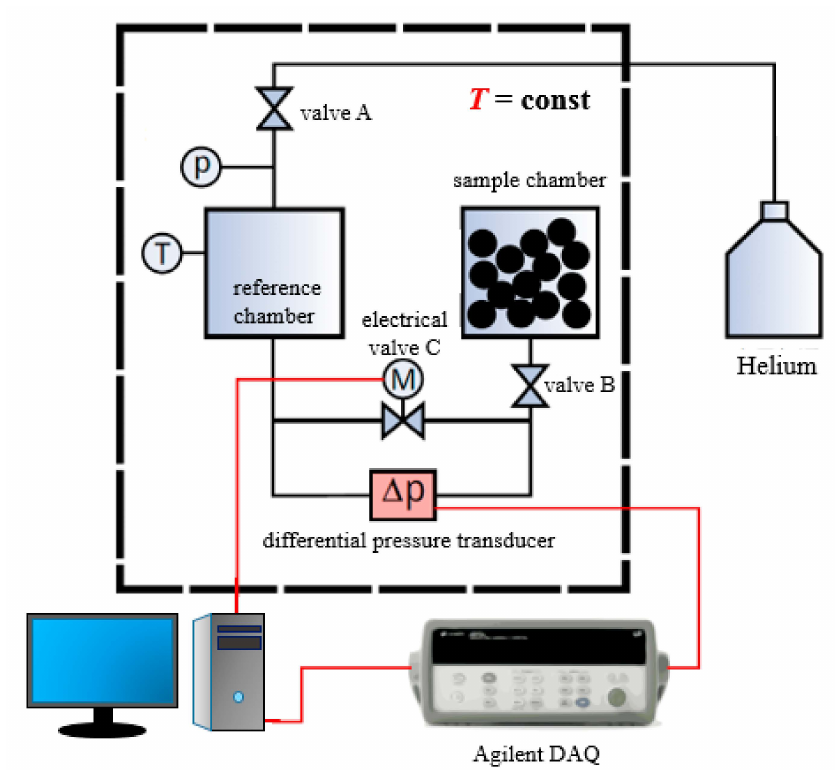
Figure 3. Schematic diagram of the experimental system used for the measurement of shale matrix particle permeability. Shale particle samples are placed in the sample chamber, and a reference chamber with approximately the same volume as the sample chamber is used for gas bu ff ering. The electrical valve C is automatically controlled by the computer. The whole system is placed in a thermostatic water bath to maintain a constant